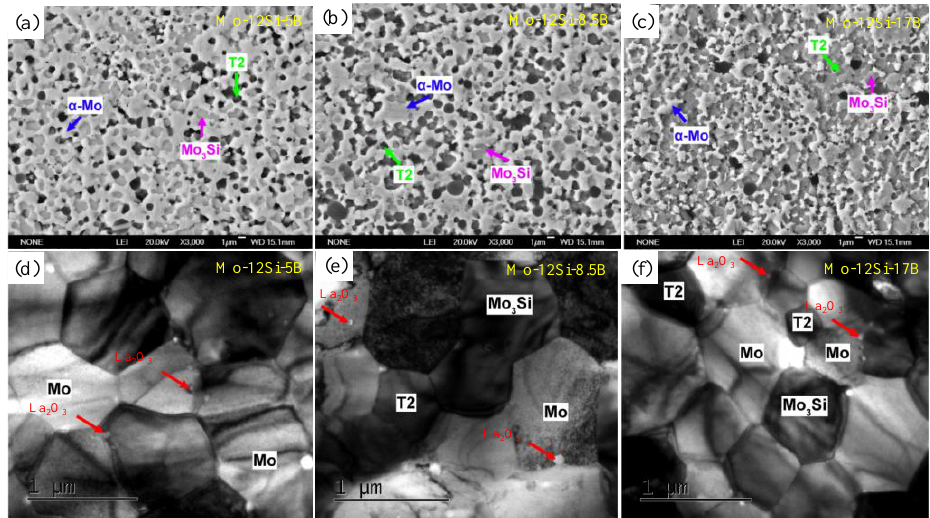
Figure 3. Typical SEM ( a – c ) and TEM bright field images ( d – f ) present the micromorphology of three different alloys. Reproduced with permission [44]. Copyright 2019 Elsevier.